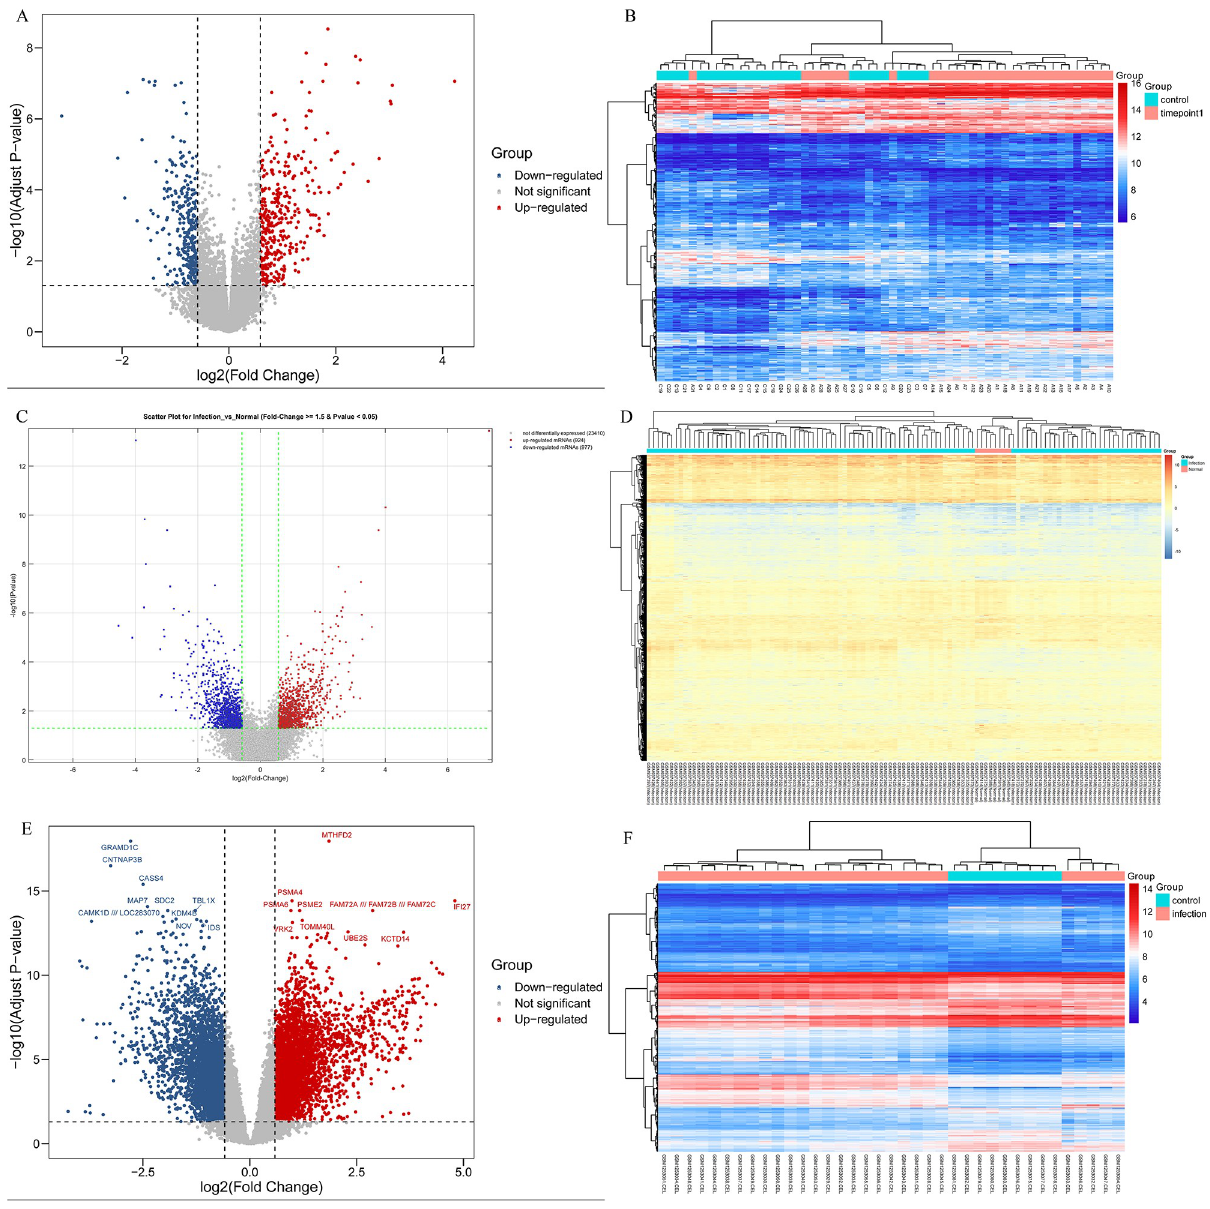
Fig 1. Volcano map and heat map of differentially expressed genes (DEGs) in GSE28405(AB), GSE38246(CD), and GSE51808(EF). (ACE) Red dots indicated up-regulated genes and blue dots indicated down-regulated genes. Black dots indicated the rest of the genes with no significant expression change. The threshold was set as followed: P < 0.05 and |log2FC| � 2. FC: fold change. (BDF) Gene expression data is converted into a data matrix. Each column represents the genetic data of a sample, and each row represents a gene. The color of each cell represents the expression level, and there are references to expression levels in different colors in the upper right corner of the